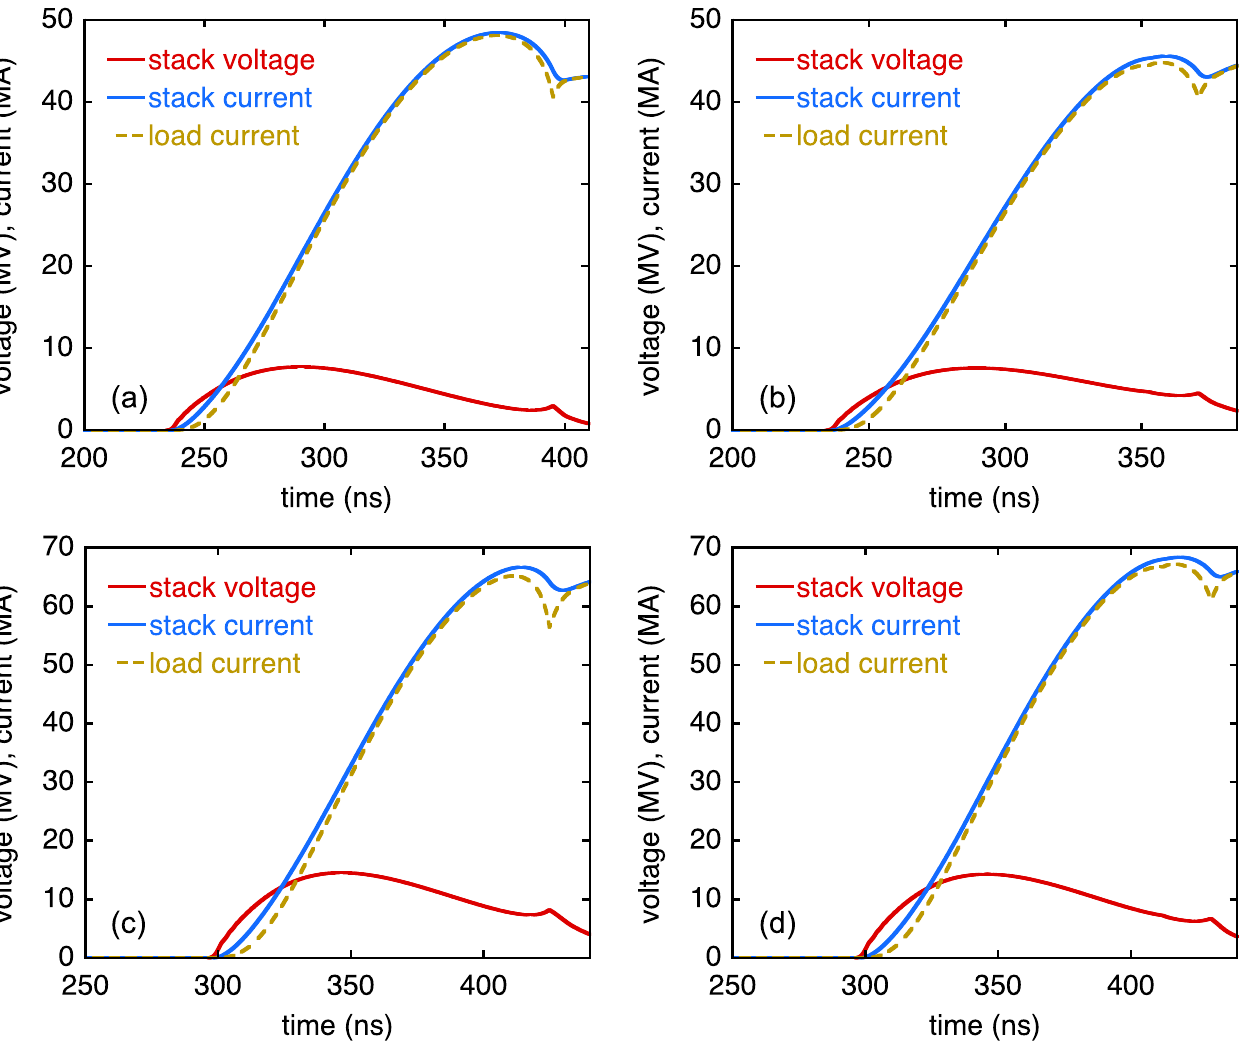
FIG. 10. Simulated time histories of the voltage on the vacuum side of the insulator stack, current at the stack, and load current for (a) a Z-300 shot conducted with a MagLIF load; (b) a Z-300 shot conducted with a dynamic hohlraum; (c) a Z-800 shot conducted with a MagLIF load; and (d) a Z-800 shot conducted with a dynamic